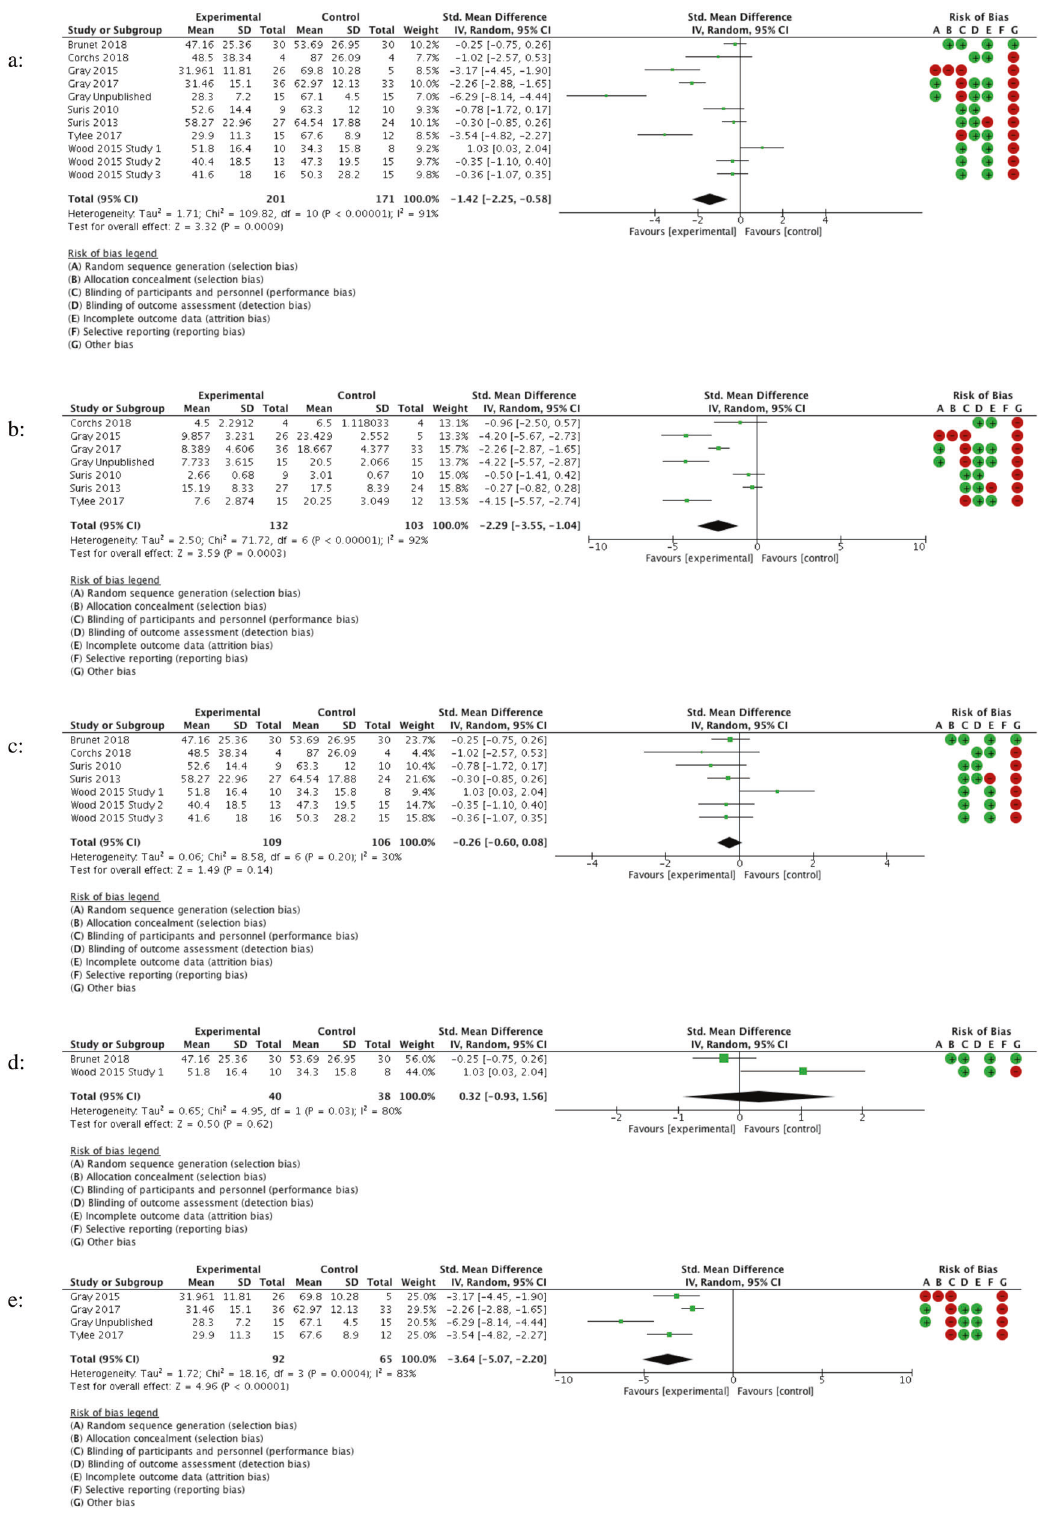
Fig. 2 Forest plots of effects of reconsolidation therapies for PTSD treatment in adult participant RCTs. a All pharmacological/ECT/ psychological reconsolidation interventions assessing PTSD severity at 1 – 4 weeks. b All pharmacological/ECT/psychological reconsolidation interventions assessing re-experiencing severity at 1 – 4 weeks. c All pharmacological/ECT reconsolidation interventions assessing PTSD severity at 1 – 4 weeks. d Propranolol and memory reactivation interventions assessing PTSD severity at 1 week. e RTM interventions assessing PTSD severity at 2